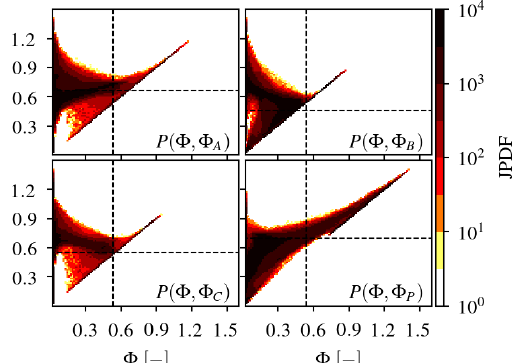
Figure A1. Joint PDF of the equivalence ratio Φ and the equivalence ratio of the individual stages Φ A , Φ Φ Φ B , P for case 1C. Vertical and horizontal dashed lines mark nominal global ( C and fuel stage equivalence